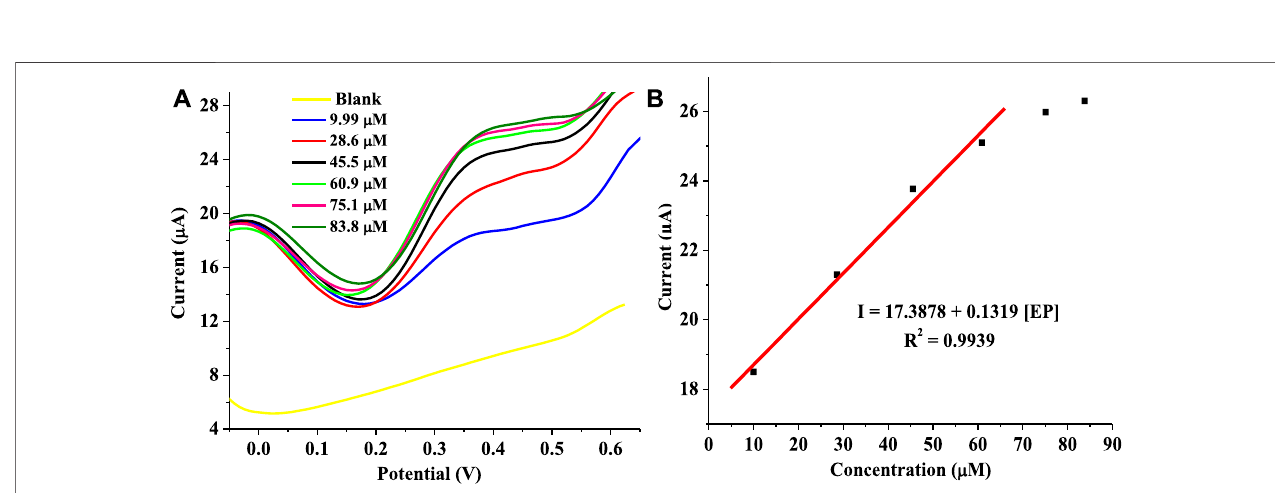
FIGURE8|(A) SquarewavevoltammogramofEPredoxprocesswithEPconcentrationchanges(9.99 – 83.8 μ M)at10 mVpotentialstep,10 mVamplitude,10 Hz frequency, pH 7, and scan rate of 25 mV s − 1 . (B) Plot of current against [EP].